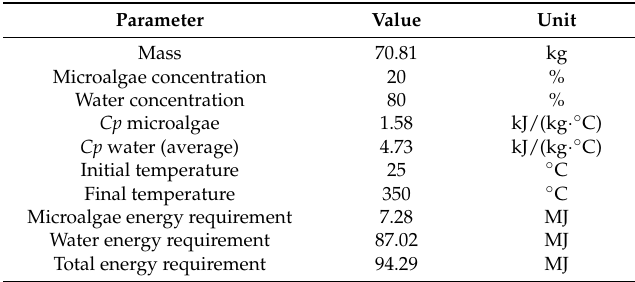
Table 7. Parameters used in the hydrothermal liquefaction (HTL) energy